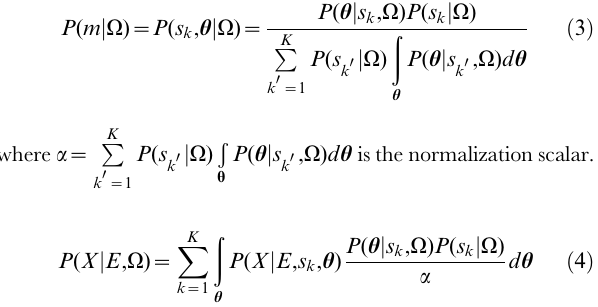
Gene DifferentiationAttractor